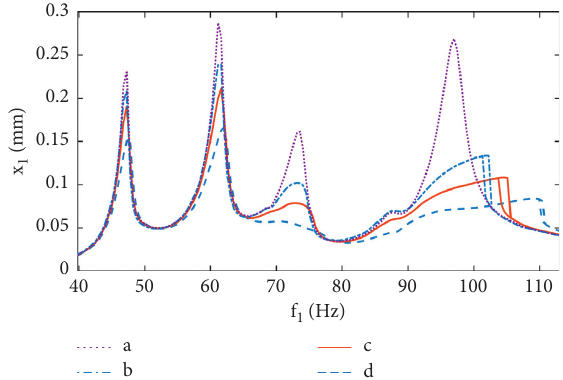
Figure 9: Amplitude-frequency curves when front low-pressure SFD is implemented (a: no SFD, b: 0.25mm, c: 0.20mm, d: 0.15mm).